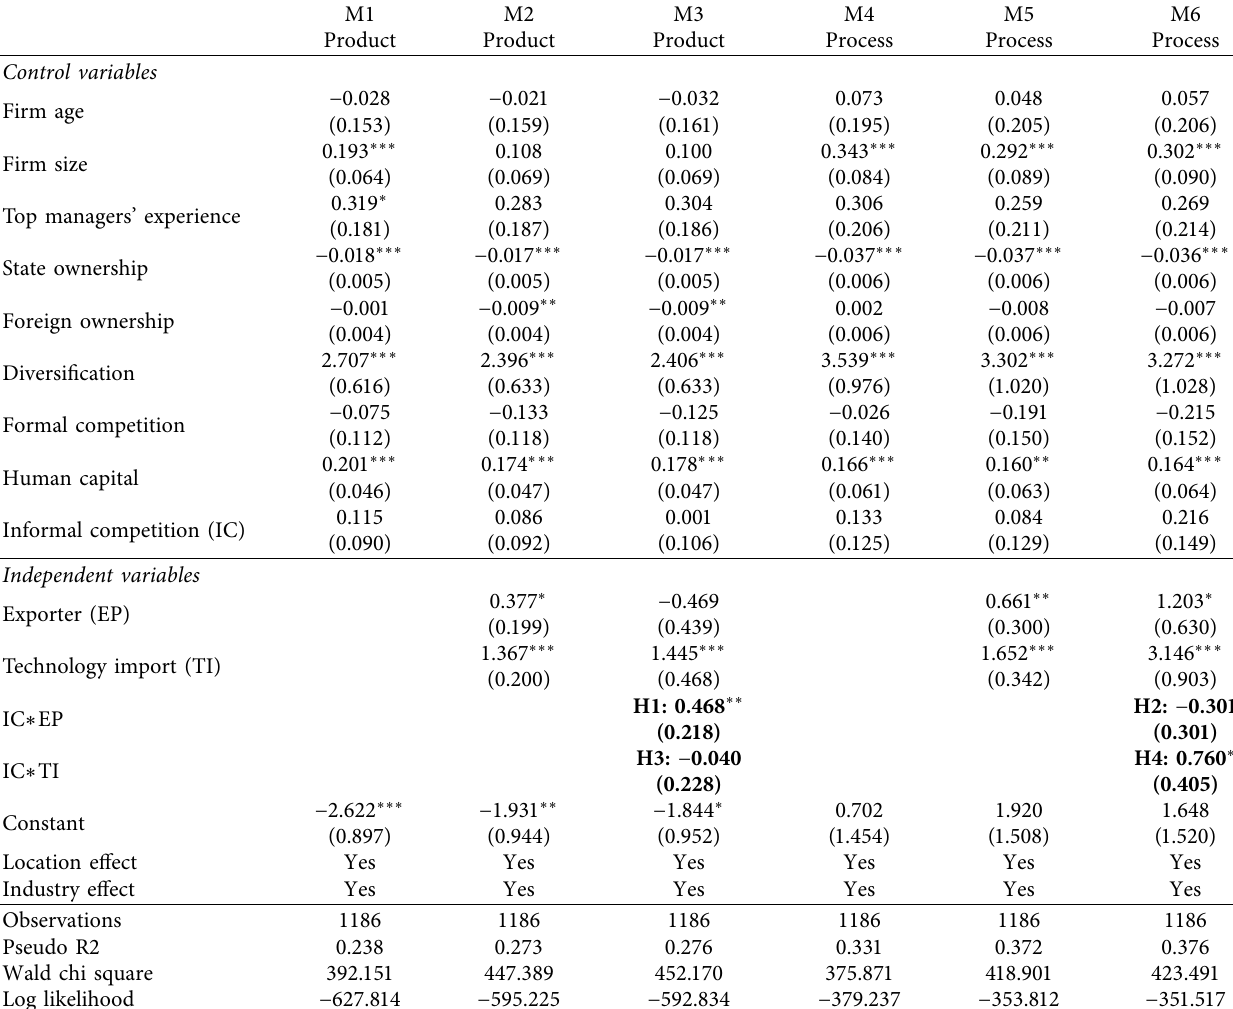
Table 4: Logit regressions